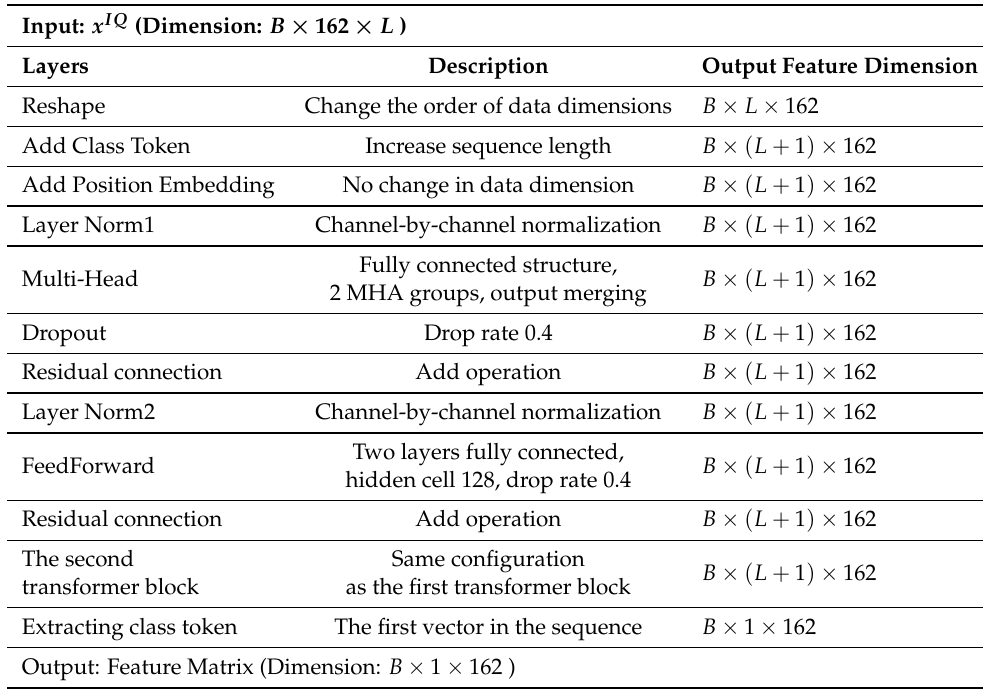
Table 2. The hyperparameters of the two Transformer blocks.